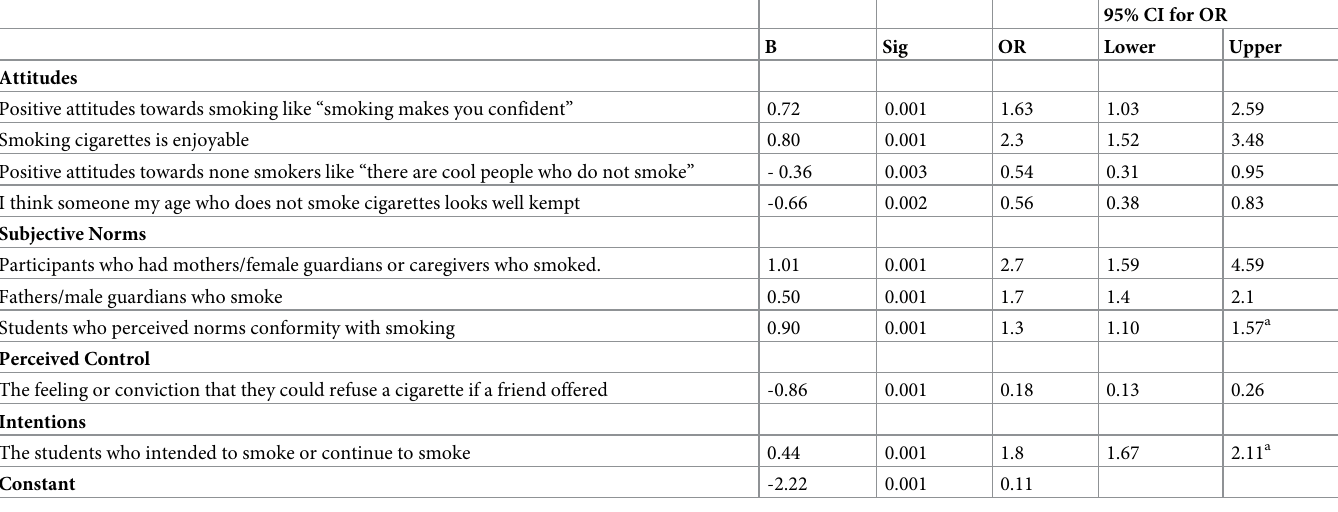
Table 2. Logistics regression with TPB constructs to predict current cigarette